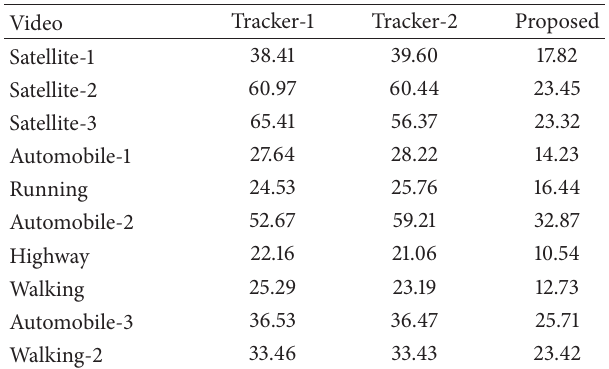
Table 1: Results of the averaged Euclidian distance over all frames in each video.